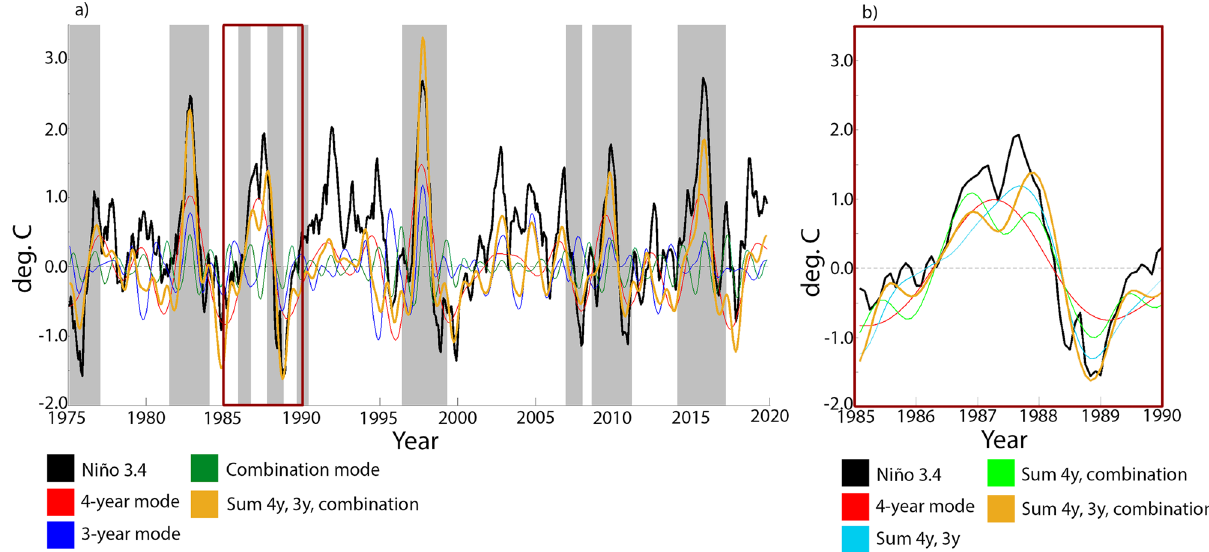
Fig. 10 Raw (solid black line) and reconstructed (colored lines) Niño 3.4 index for the ERSSTv4 data. The reconstructions are based on groups of eigenfunctions of the generator from Fig. 3 and Supplementary Table 3. See Methods for a description of the reconstruction procedure. a Reconstructions over the period January 1975 to February 2020 based on (i) the fundamental (4-year) ENSO pair, g 5 , g 6 (red); (ii) leading two ENSO combination pairs, g 10 , g 11 , g 15 , g 16 (green); (iii) 3-year ENSO pair, g 19 , g 20 (blue); and (iv) the sum of the modes in (i – iii) (orange). The eigenfunction index sets J (see Methods) employed for these reconstructions are (i) {5, 6}; (ii) {10, 11, 15, 16}; (iii) {19, 20}; and (iv) {5, 6, 10, 11, 15, 16, 19, 20}. Time intervals (shaded gray) indicate periods where the running correlation coef fi cient between the Niño 3.4 index and the reconstructed index based on all modes (Case (iv); orange line) exceeds 0.9. The running correlation coef fi cient was computed using a two-month (centered) sliding window. b A detailed view of the “ double-peaked ” 1986/87 El Niño, highlighting the role of the combination modes (see green line) in reconstructing the double peak of the Niño 3.4 index. The time interval depicted in b is indicated by a red box in a